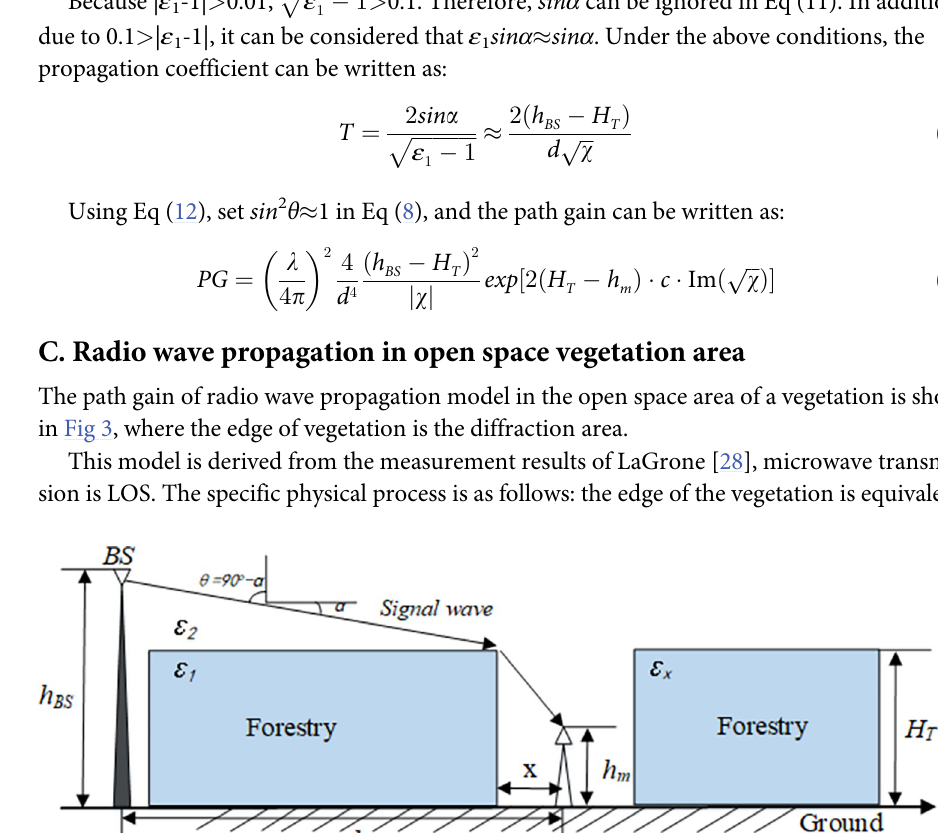
ffiffiffiffiffiffiffiffiffiffiffiffiffi ε 1